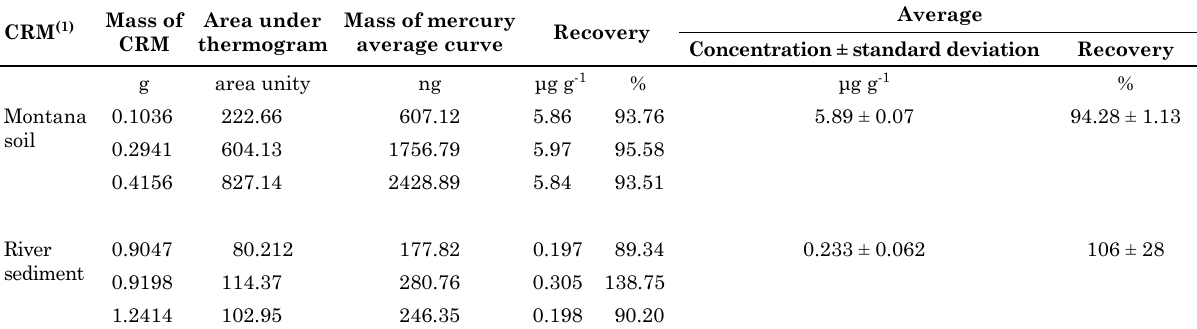
Table 4. Concentration and recovery percentage of mercury in certified reference materials by the proposed thermal desorption associated with atomic absorption spectrometry method